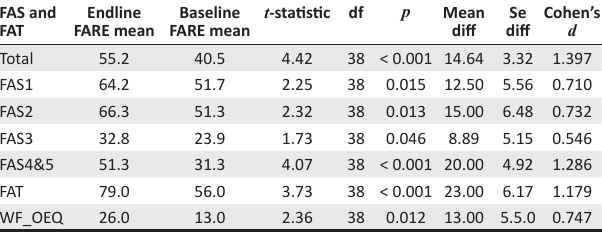
TABLE 2: Baseline and endline paired samples t -test (95 % confidence levels). FAS and FAT